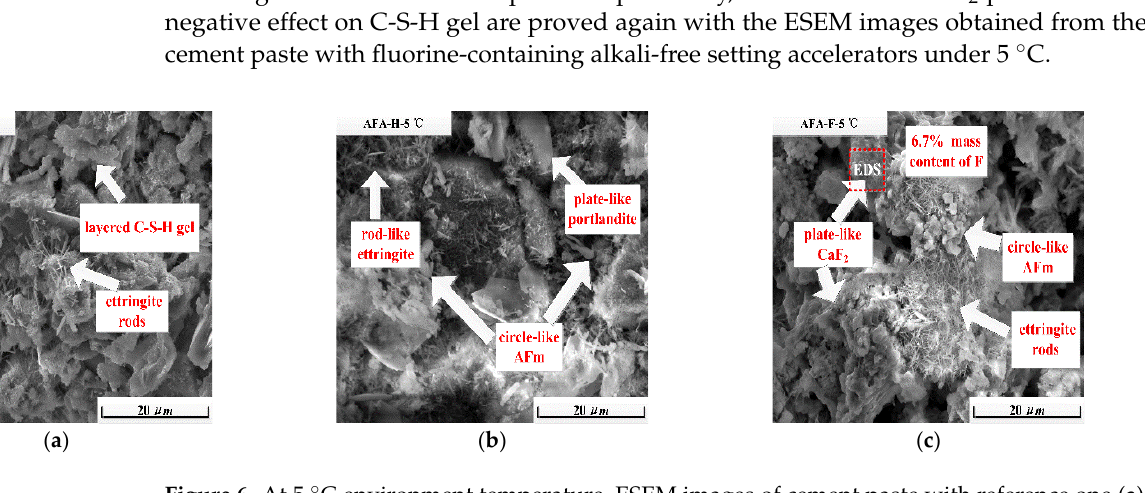
Figure 5. At 20 °C environment temperature, ESEM images of cement paste with reference one ( a ), alkali-free accelerators without fluoride ( b ), and with fluoride ( c ) at 24 h of hydration.